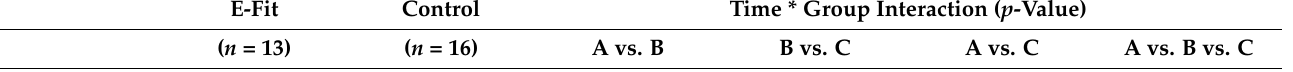
Table 3. The means of physical activity level and quality of life measures over time of the subjects. E-Fit Control Time * Group Interaction ( p -Value) ( n = 13) ( n = 16) A vs. B B vs. C A vs. C A vs. B vs.